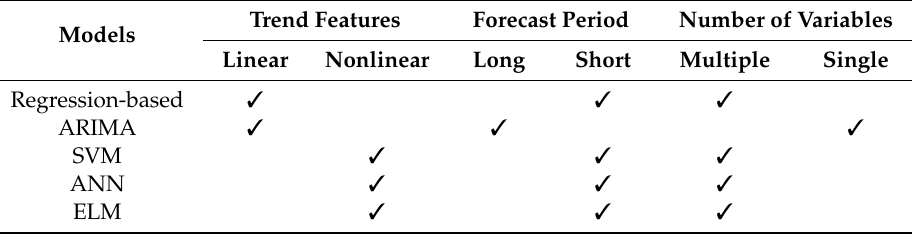
Table 2. Comparison of di ff erent forecasting models for energy